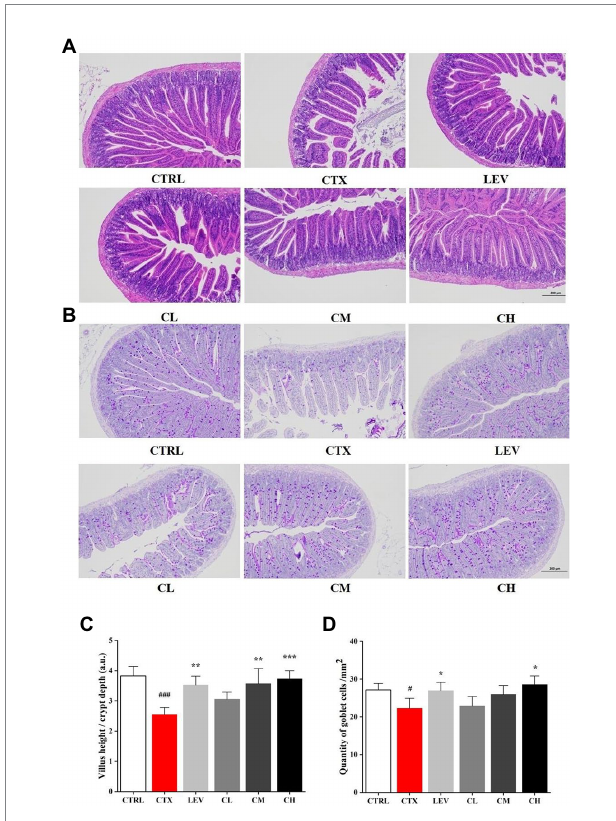
FIGURE 2 Complex probiotics treatments relived intestinal immune disorder in CTX-induced immunosuppression mice. ( n = 8 for each group). (A) HE staining of jejunum section (100×, Scale bar = 200 mm). (B) AB- PAS staining of jejunum section. (100×, Scale bar = 200 mm). (C) The ratio of villus height/crypt depth. (D) The quantity of goblet cells/mm 2 . CTRL, normal control group; CTX, model control group; LEV, levamisole hydrochloride; CL, low-dose complex probiotics; CM, Medium-dose complex probiotics; CH, high-dose complex probiotics. All data are expressed as mean ± SD. # p < 0.05, ## p < 0.01, ### p < 0.001 compared with CTRL; * p < 0.05, ** p < 0.01, *** p < 0.001 compared with CTX.